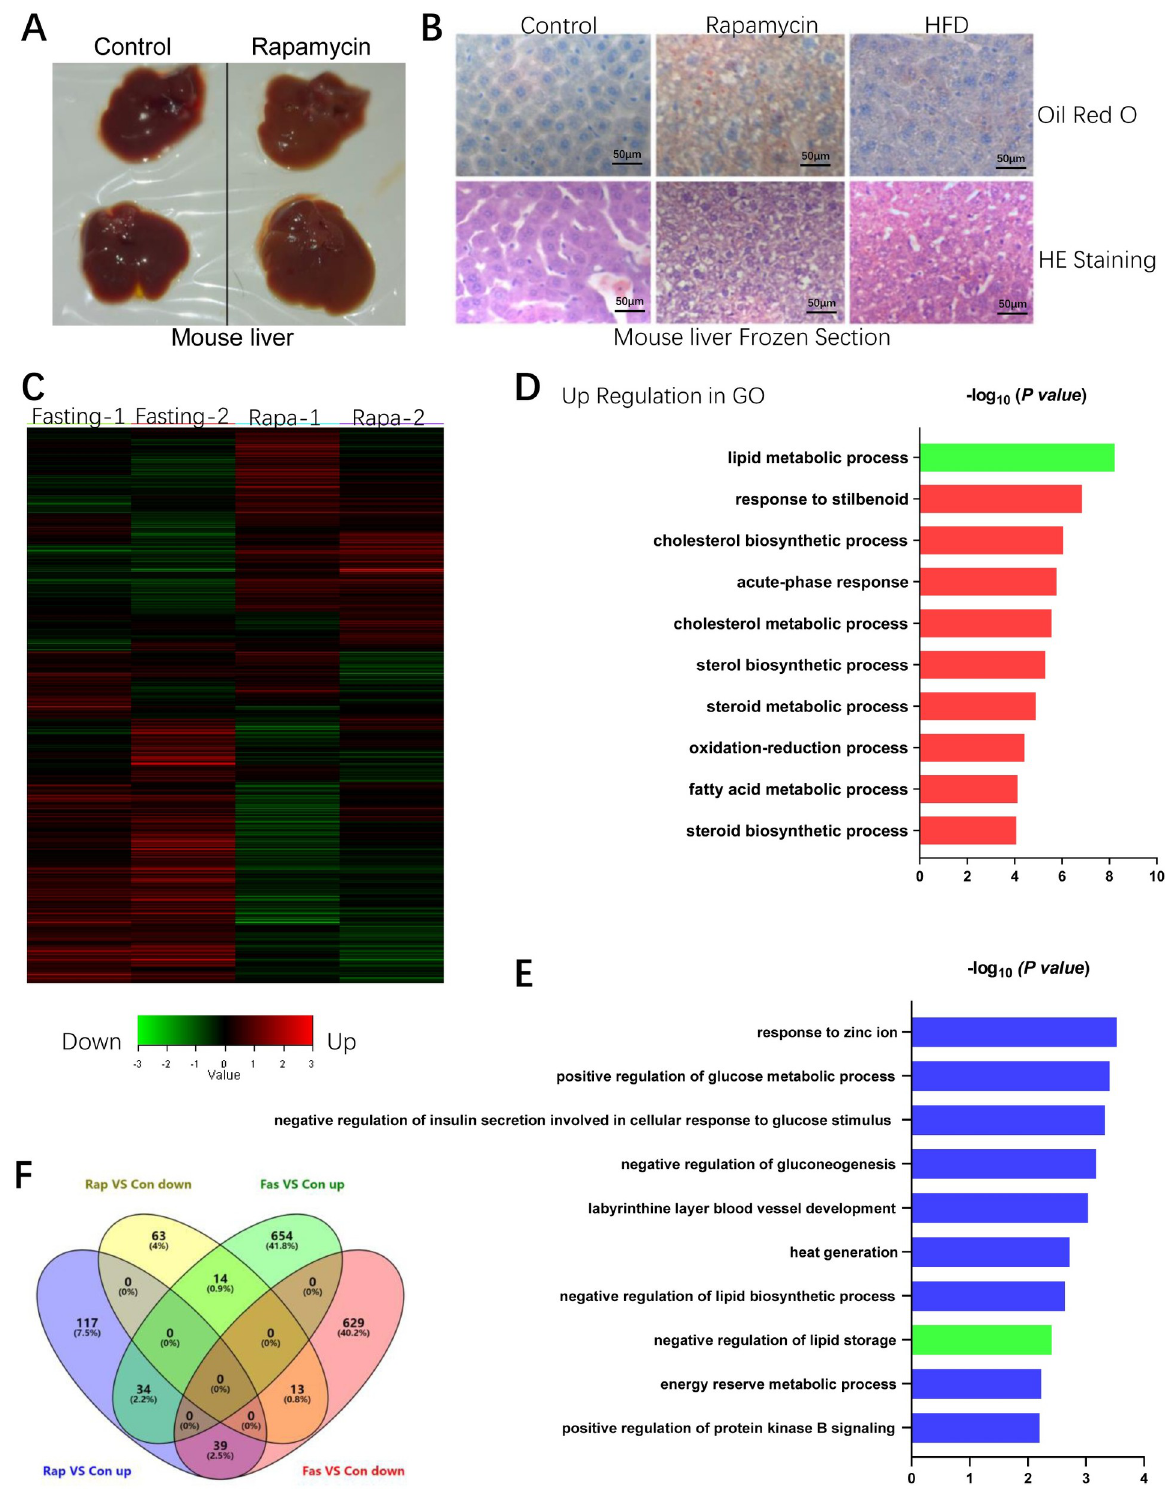
Fig 1. Rapamycin-induced lipid accumulation in mouse liver. (Control group n = 7, rapamycin treated group n = 8; Data represent mean ± SD, �� p < 0.01, � p < 0.05). A. Mouse livers of rapamycin-treated group and control group. B. Oil red O staining indicates remarkable lipid accumulation in rapamycin-induced fatty livers. HFD group: mice were fed with the high fat diet for two months. C. Microarray analysis revealed